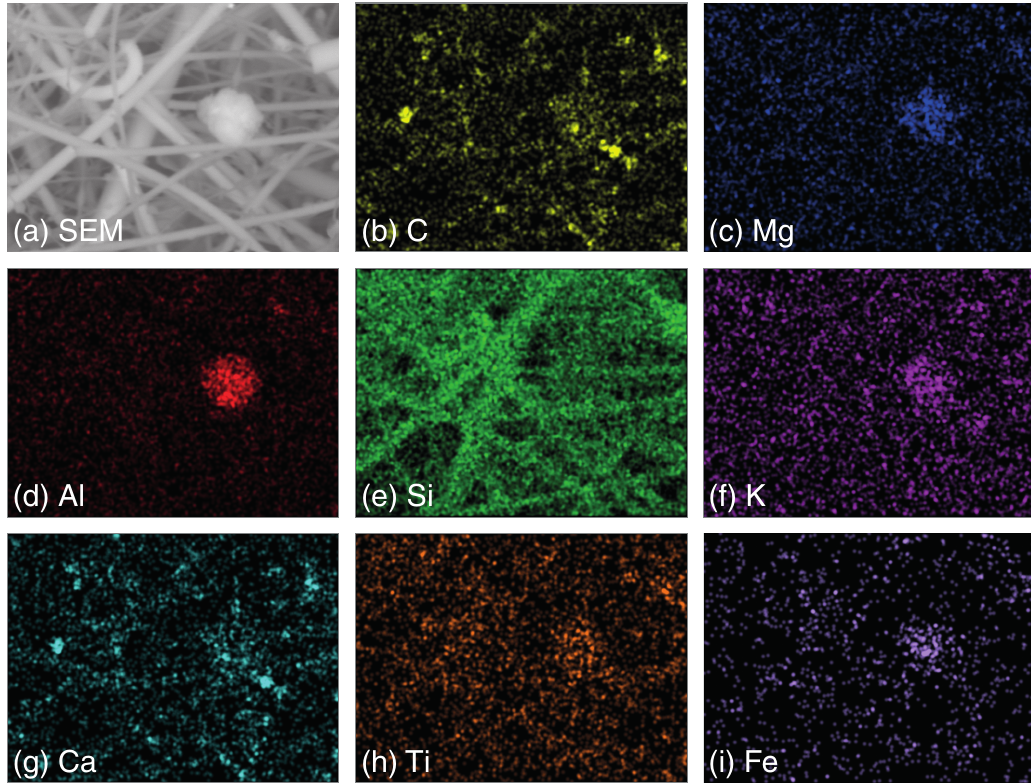
Figure 8. Single particle SEM/EDX map collected by Low Volume Sampler (LVS3) on a quartz filter for 24 h starting on 22 March 1500 UTC. (a) SEM image, (b)–(i) elemental composition derived from EDX for C, Mg, Al, Si, K, Ca, Ti,